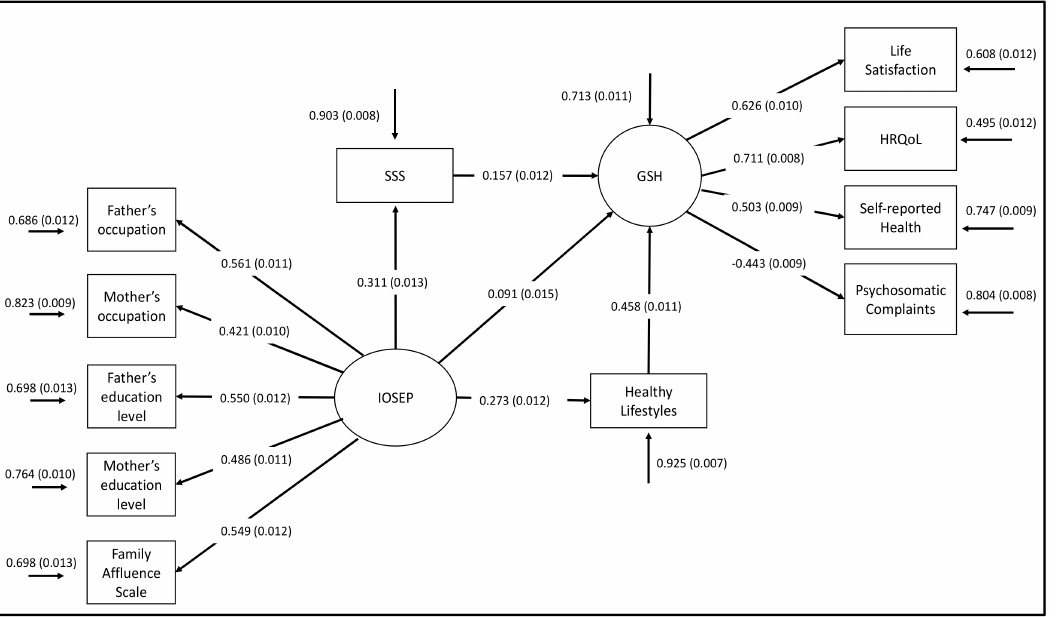
Figure 2. Path coe ffi cient estimates of the final model (Model 7). Note: IOSEP, index of objective SEP; SSS, subjective socioeconomic status; GSH, global score of health; HRQoL, health-related quality of life. The error terms of the variables maternal and paternal education, and those from the variables maternal education and maternal occupation were allowed to covary, as was previously demonstrated in Moreno-Maldonado, Rivera, Ramos, and Moreno [16]. The error term of the IOSEP was not estimated, being fixed to 1. p <